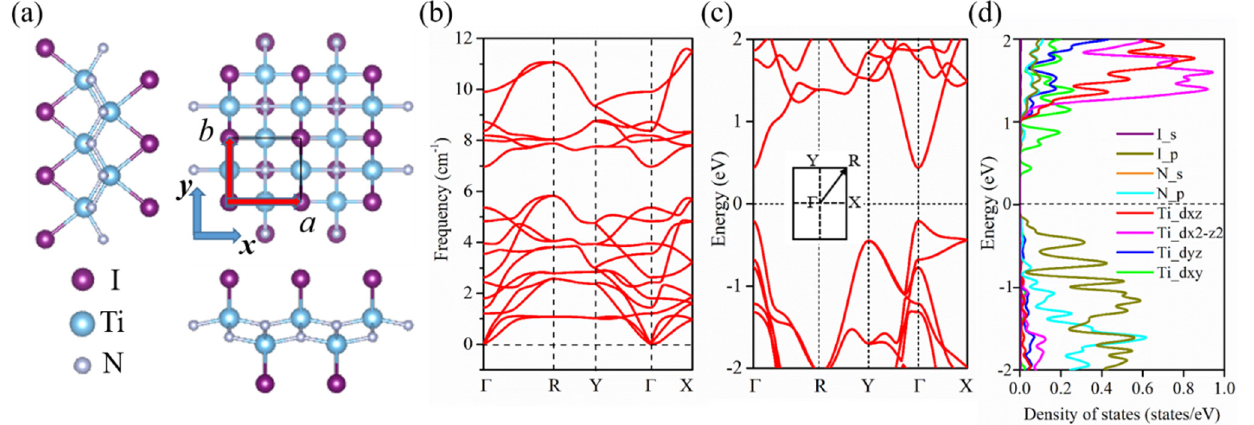
Figure 1. ( a ) Crystal structure diagram of two − dimensional TiNI. ( b ) Phonon dispersion curves of two − dimensional TiNI. ( c ) Electronic band diagram. ( d ) DOS for two − dimensional TiNI.